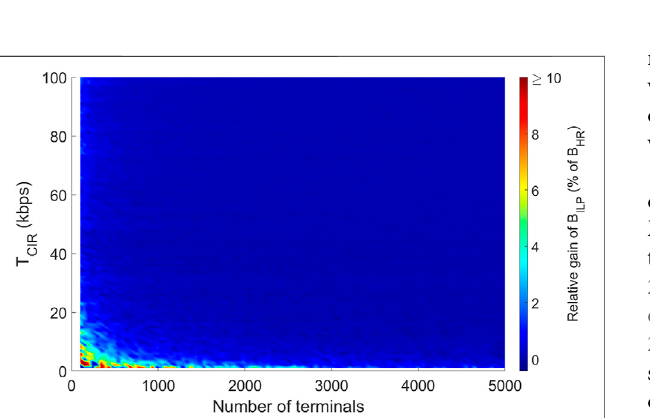
FIGURE 7 | Relative gain of B ILP compared to B IT in function of number of user terminals and T CIR .